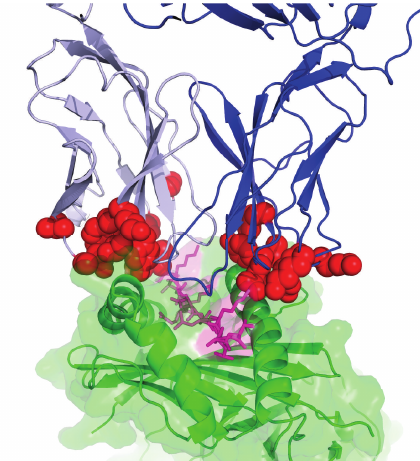
Figure 4: TRAV and TRBV polymorphic positions shown on a TCR/pMHC complex structure. Polymorphic positions are red, TCR 𝛼 is light blue, TCR 𝛽 is blue, peptide is magenta, and MHC is green. Structure shown is HA1.7 TCR/HA peptide/HLA-DR4 (Protein Data Bank [43] ID 1J8H). The figure was generated using PyMOL